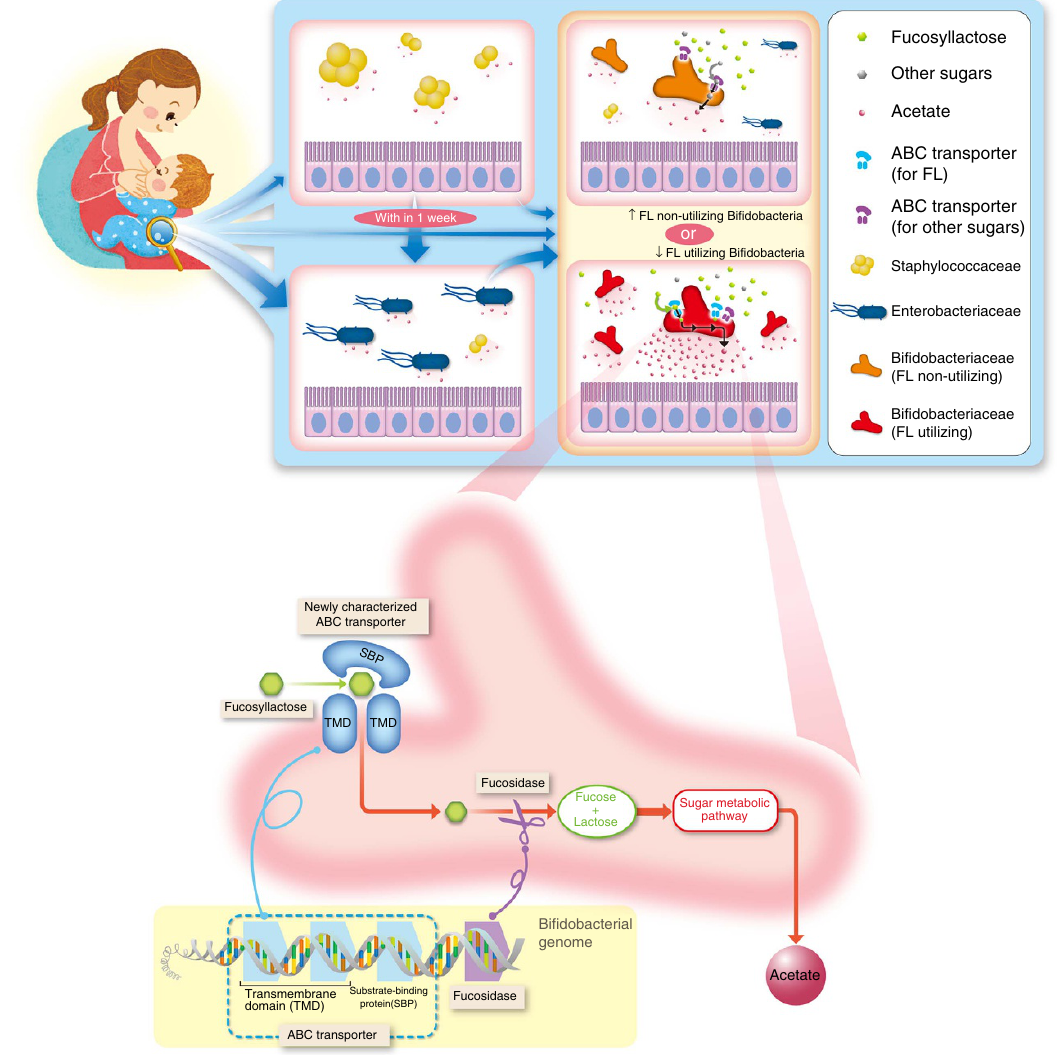
Figure 6 | Infant microbiota development and molecular mechanisms of FL utilization by bifidobacteria. Infant gut microbiota showed 3 distinct clusters, which underwent directional transition to Bifidobacteriaceae-dominant microbiota, and displayed individual variations in the pace of progression. Isolated bifidobacterial strain showed differences in FL utilization. Colonization of FL-utilizing bifidobacteria are associated with altered gut acetate concentrations, pH, and Enterobacteriaceae and Bifidobacteriaceae abundances in the cohort, which have been previously shown to affect infant health. We subsequently identified a SBP of the multiple-sugar ABC transporter system is a key genetic factor of FL